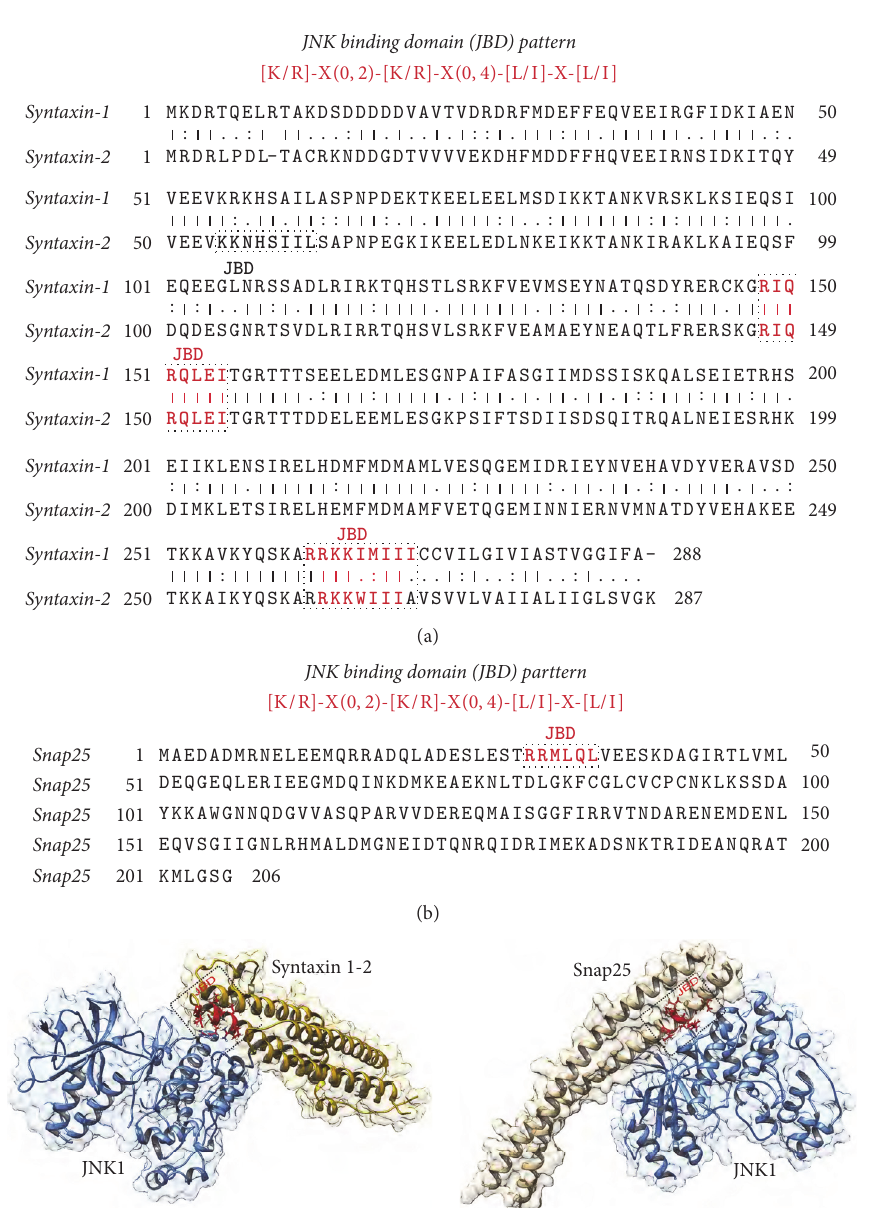
synaptosomal lysates was performed. According to data traceable in JNK’s coprecipitate (Figure 4(d)). However,